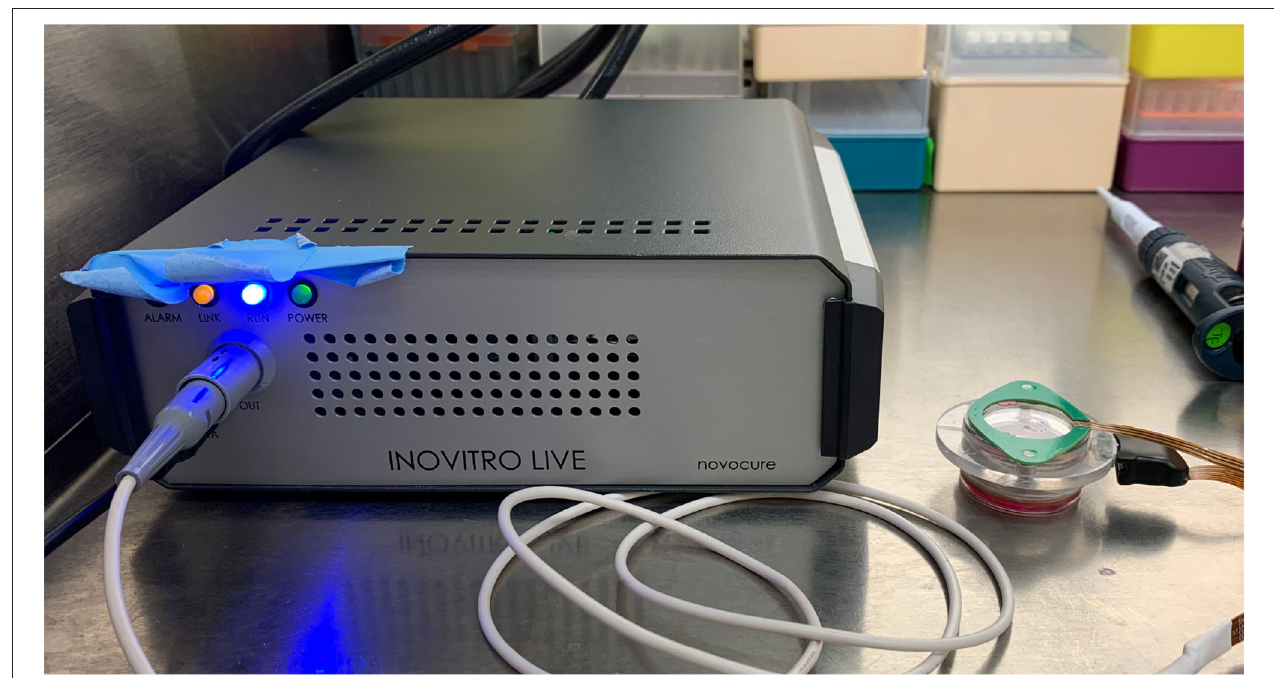
FIGURE 1 | A digital photograph of the inovitro live system. The inovitro live TTFields generator is shown on the left with the ceramic insert and the attached cover heating element visible on the